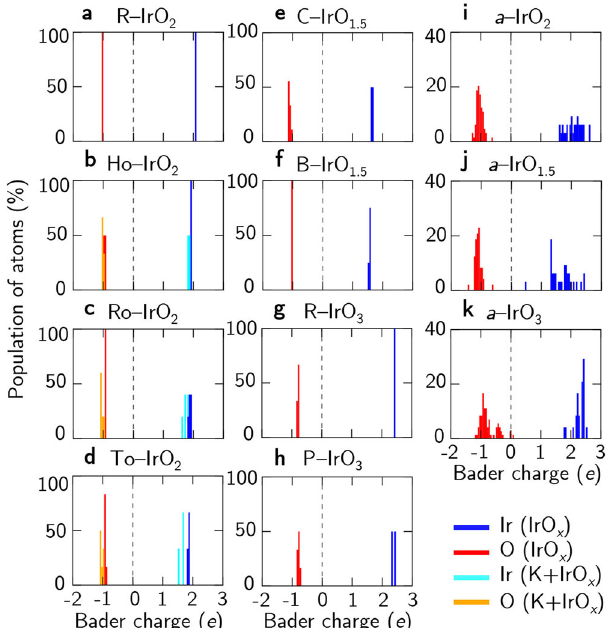
Fig. 4 Bader charge population of both Ir and O atoms. a R-IrO 2 , b Ho- IrO 2, c Ro-IrO 2 , d To-IrO 2 , e C-IrO 1.5 , f B-IrO 1.5 , g R-IrO 3 , h P-IrO 3 . i a -IrO 2 . j a -IrO 1.5 , and k a -IrO 3 . The Bader charge histogram for Ir and O atoms (without K) are denoted in blue and red bars, while that for Ir and O atoms in K-intercalated nanoporous iridium oxides are shown in cyan and yellow bars,